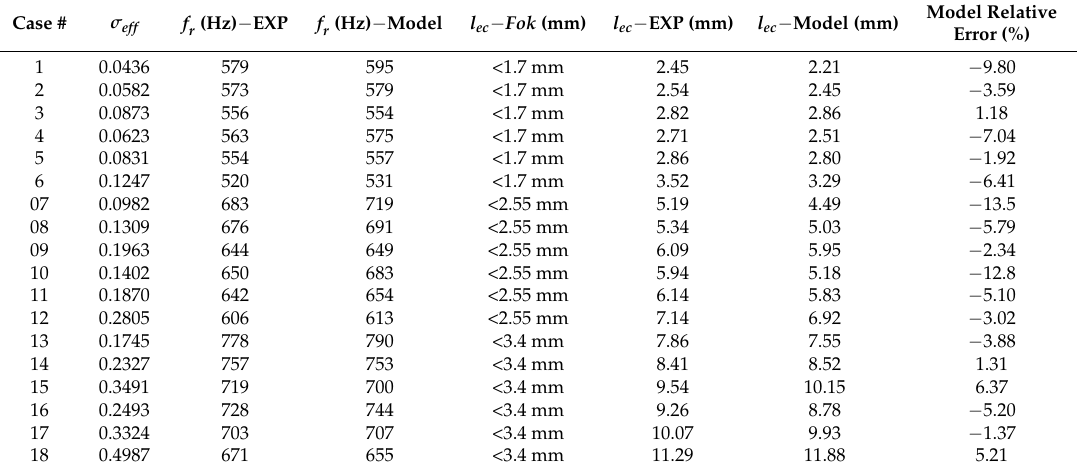
Table 4. Comparison of experimental and fitted model results for end correction lengths.